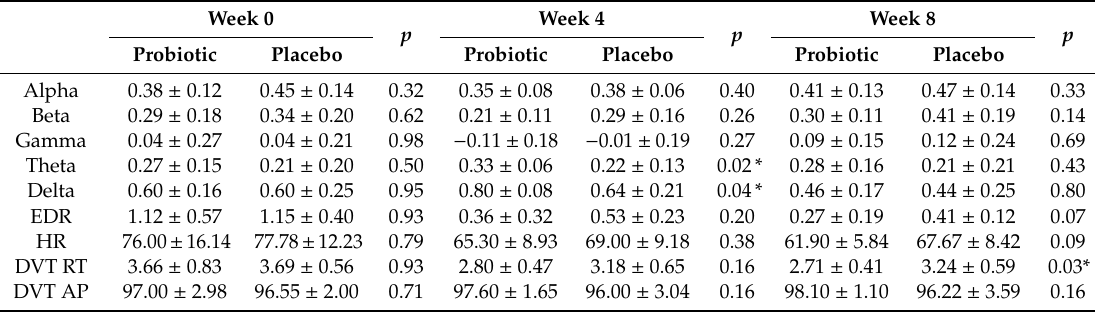
Table 3. Pairwise comparison for the between group e ff